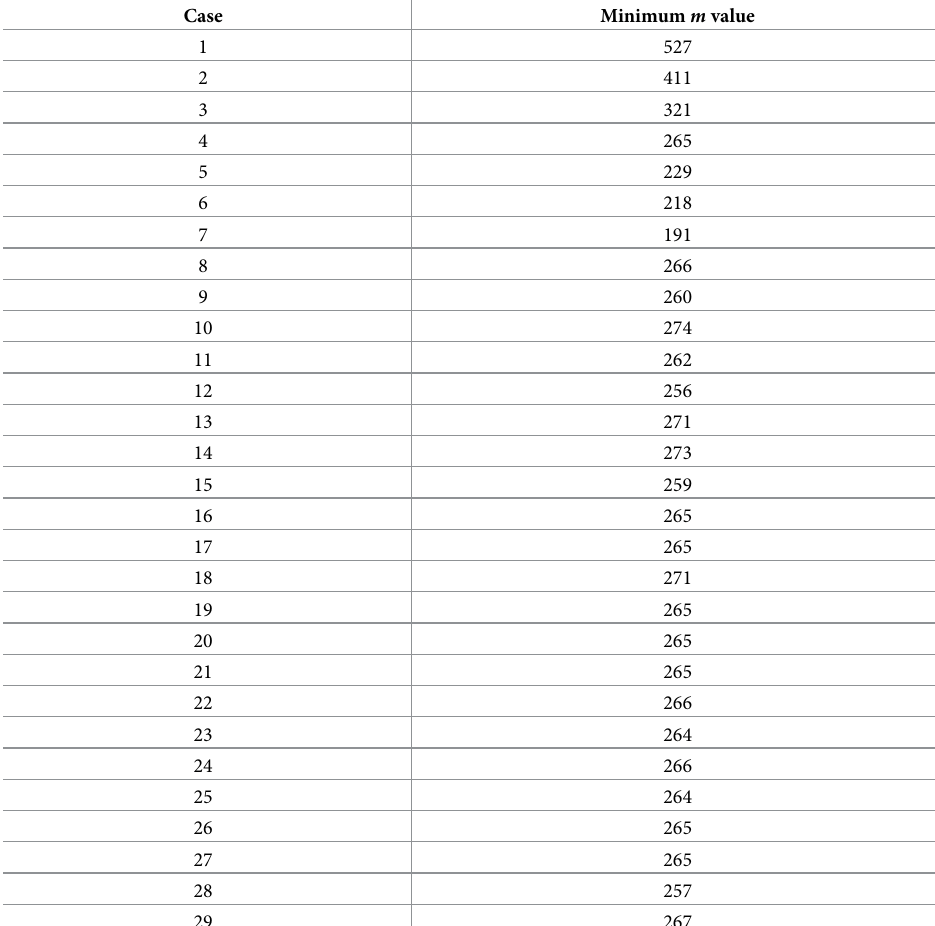
Table 4. Minimum values of m satisfying Δ <